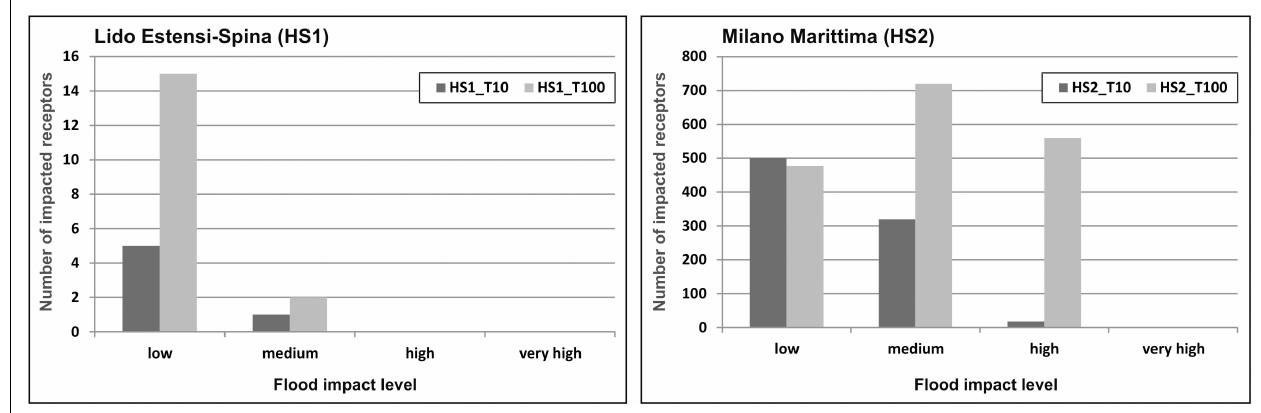
FIGURE 7 | Distribution of impact severity to the selected assets per scenarios (T10 and T100) in the two hotspots: Lido degli Estensi-lido di Spina, HS1 and Milano Marittima,